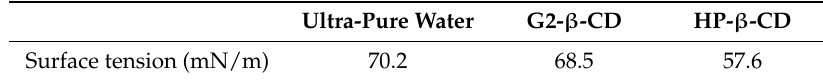
Table 1. Surface tensions of G2- β -CD and HP- β -CD solution (300 mM in ultra-pure water) measured by the du Nouy method.